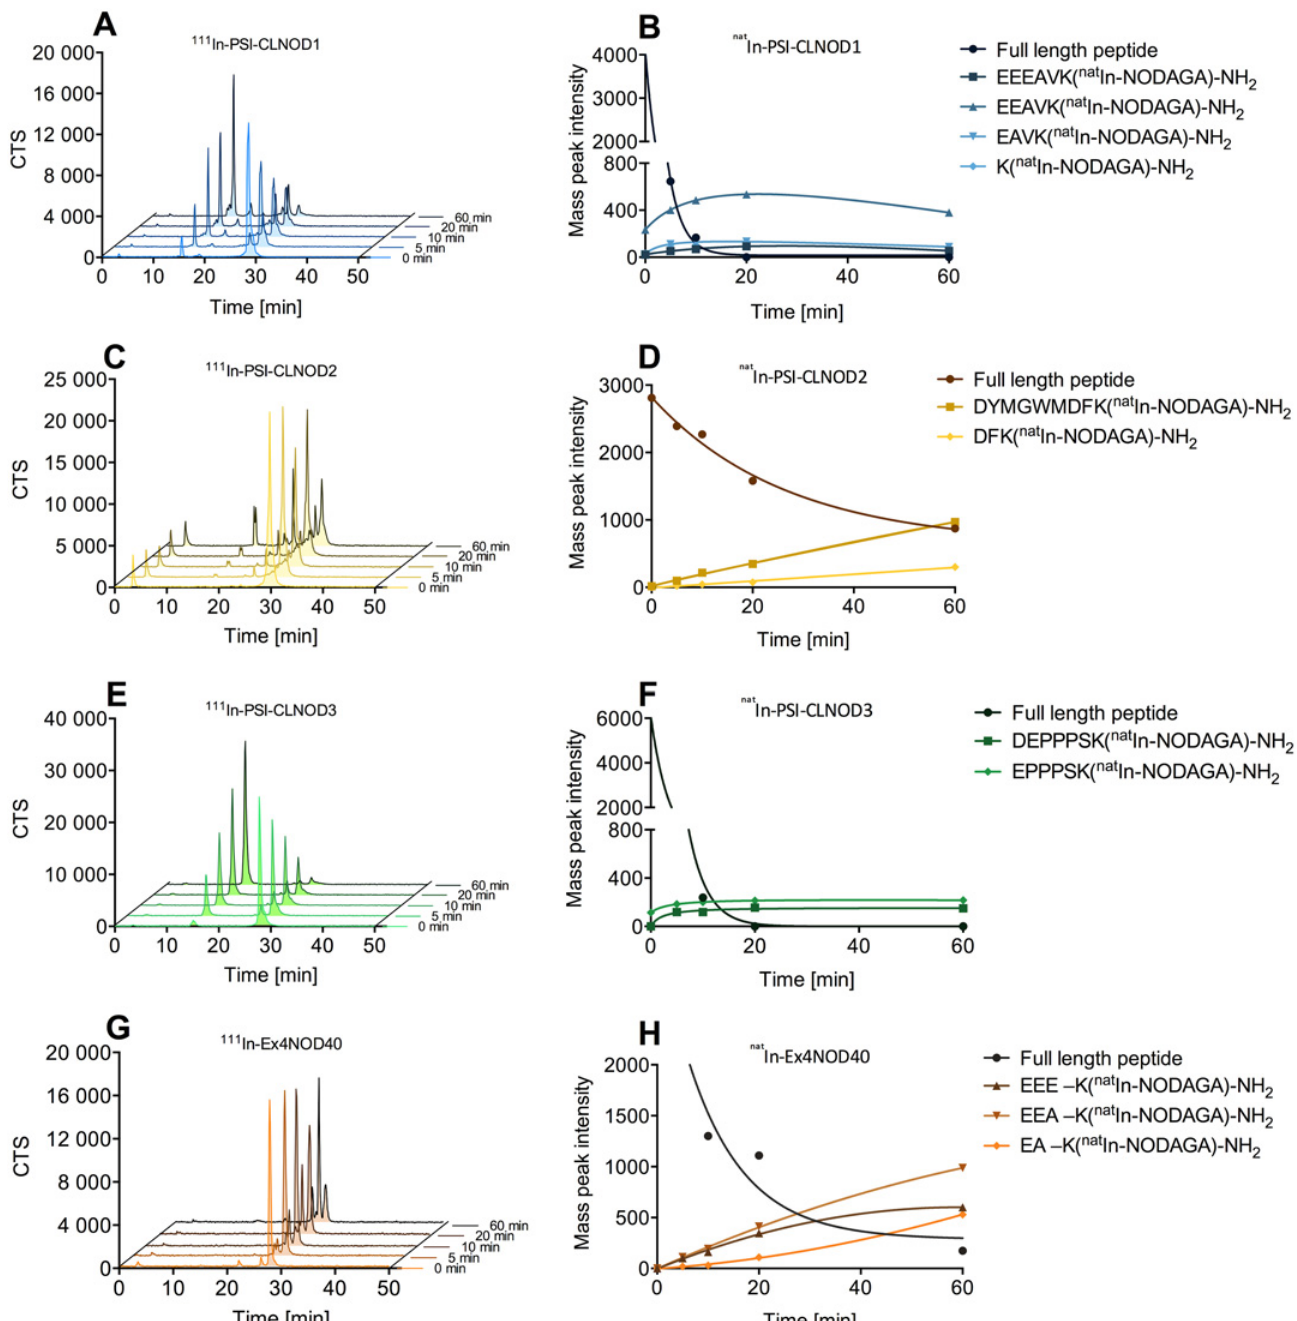
Fig 5. Digestion of In-labelled probes with recombinant meprin β . A, C, E, and G show the metabolism of the corresponding 111 In-labelled peptides. Curves B, D, F and H show the degradation of the corresponding nat In-labelled peptides and the formation of different fragments over time.